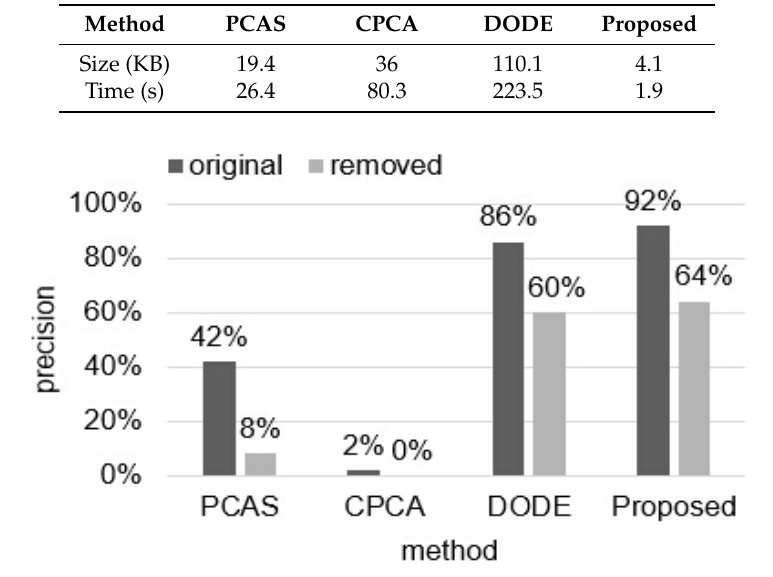
Table 1. Average feature size and matching time; PCAS: combination of PCA and SIFT; CPCA: combination of continuous PCA, normal PCA, 2D discrete Fourier transform, and 2D discrete wavelet transform; DODE: combination of dodecahedron and SIFT.